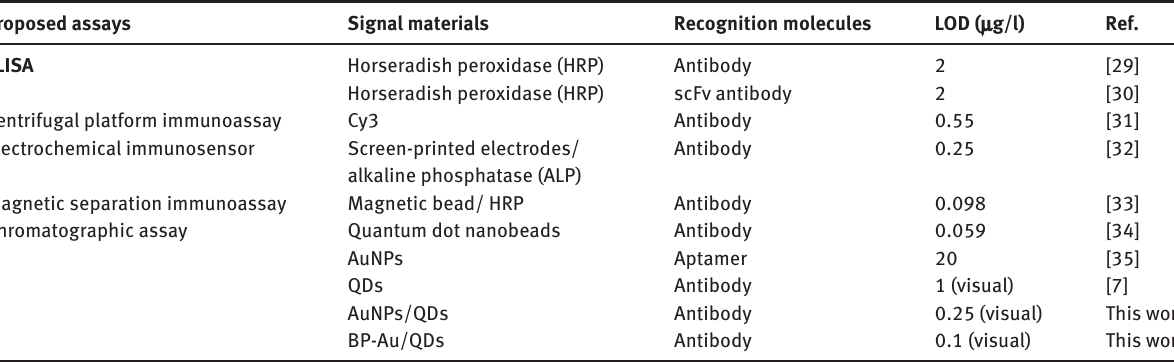
Table 1: An overview on recently reported immunoassays for the determination of zearalenone (ZEN). Proposed assays